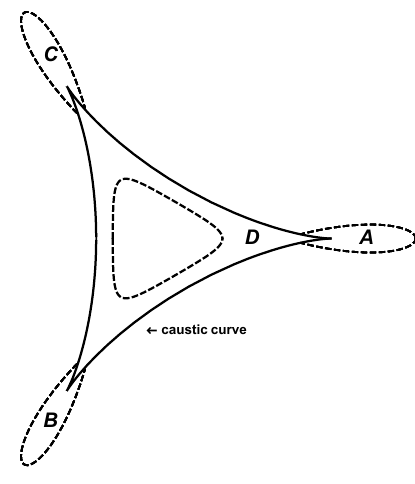
Figure 2. A generic c -slice of the elliptic umbilic caustic surface, which is the triangular-shaped solid curve. For level curves in the two-image region, which is the (unbounded) region outside the closed caustic curve, the magnification volume cross section σ ( µ ) is, for µ large enough, the sum of the closed regions A , B , C . A source inside regions A , B , or C has two lensed images and total unsigned magnification greater than µ . For level curves in the four-image region, which is inside the triangular-shaped solid curve, σ ( µ ) is, for µ large enough, the region D inside the triangular-shaped caustic but outside the closed dashed curve within. A source in region D has four lensed images and total unsigned magnification greater than µ . Note that the actual caustic and level “curve” are both surfaces in R 3 ; what is shown here is a c -slice of this surface on the source